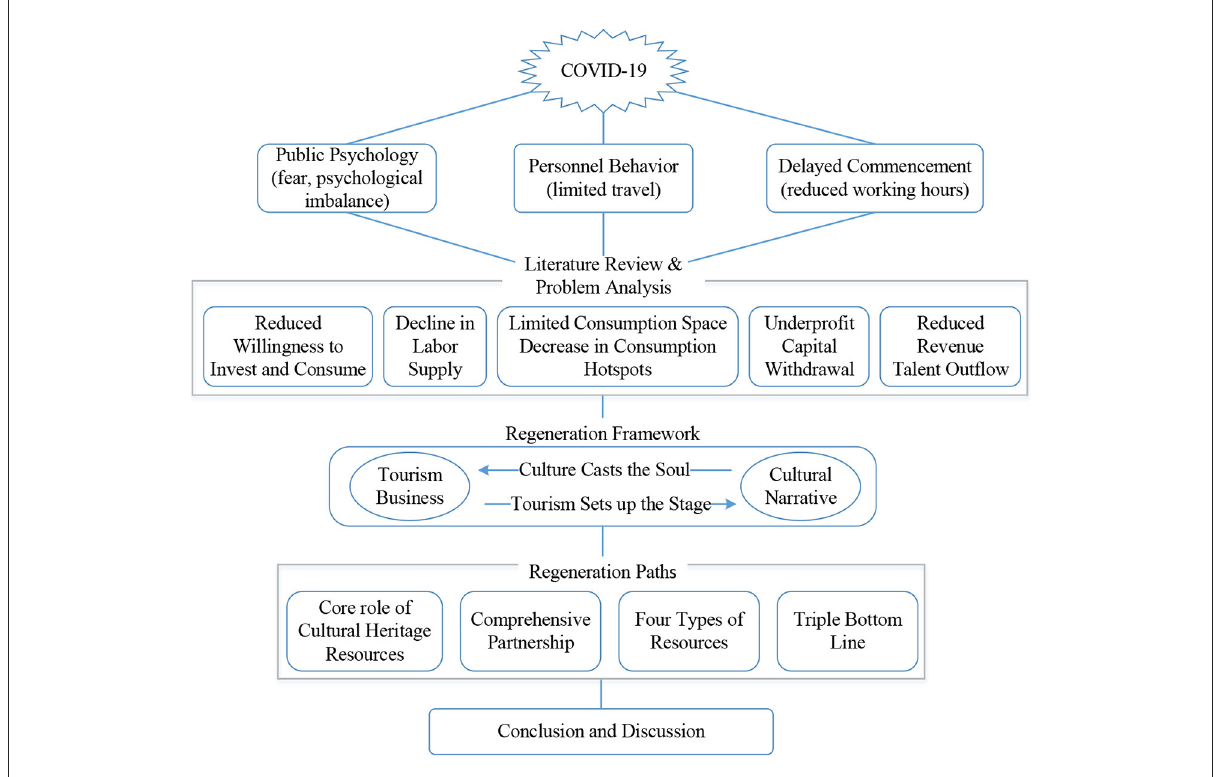
FIGURE1 The logical thinking of the research.